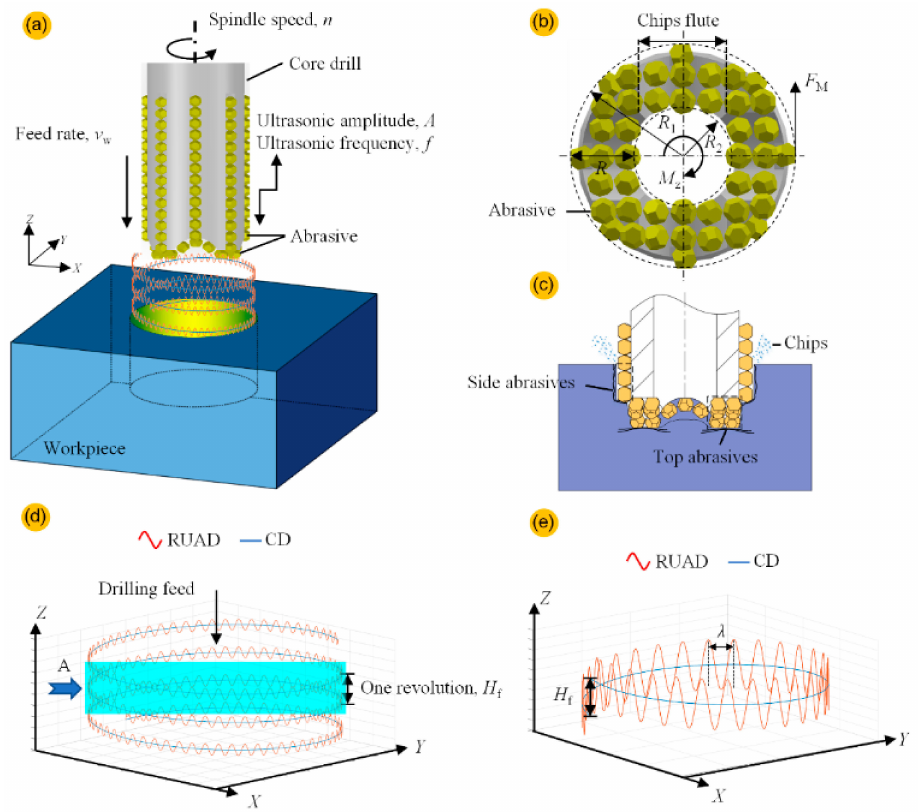
Figure 5. Diagram of the machining process, ( a ) drilling process, ( b ) tip of tool, ( c ) side of the tool, ( d ) the single abrasive grain motion trajectory during RUAD and CD, and ( e ) grain motion trajectory at one